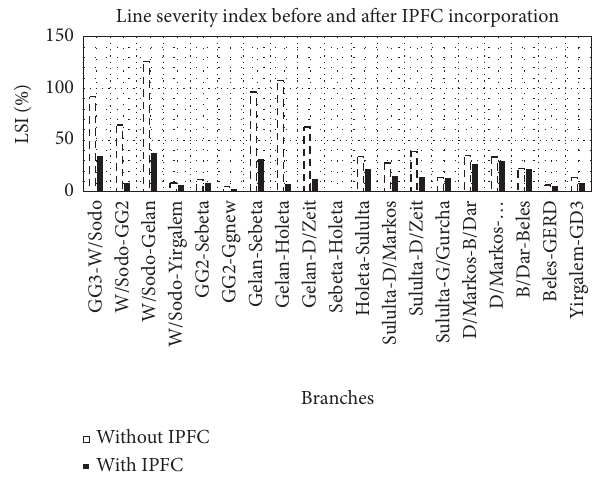
Figure 4: Line severity index before and after IPFC